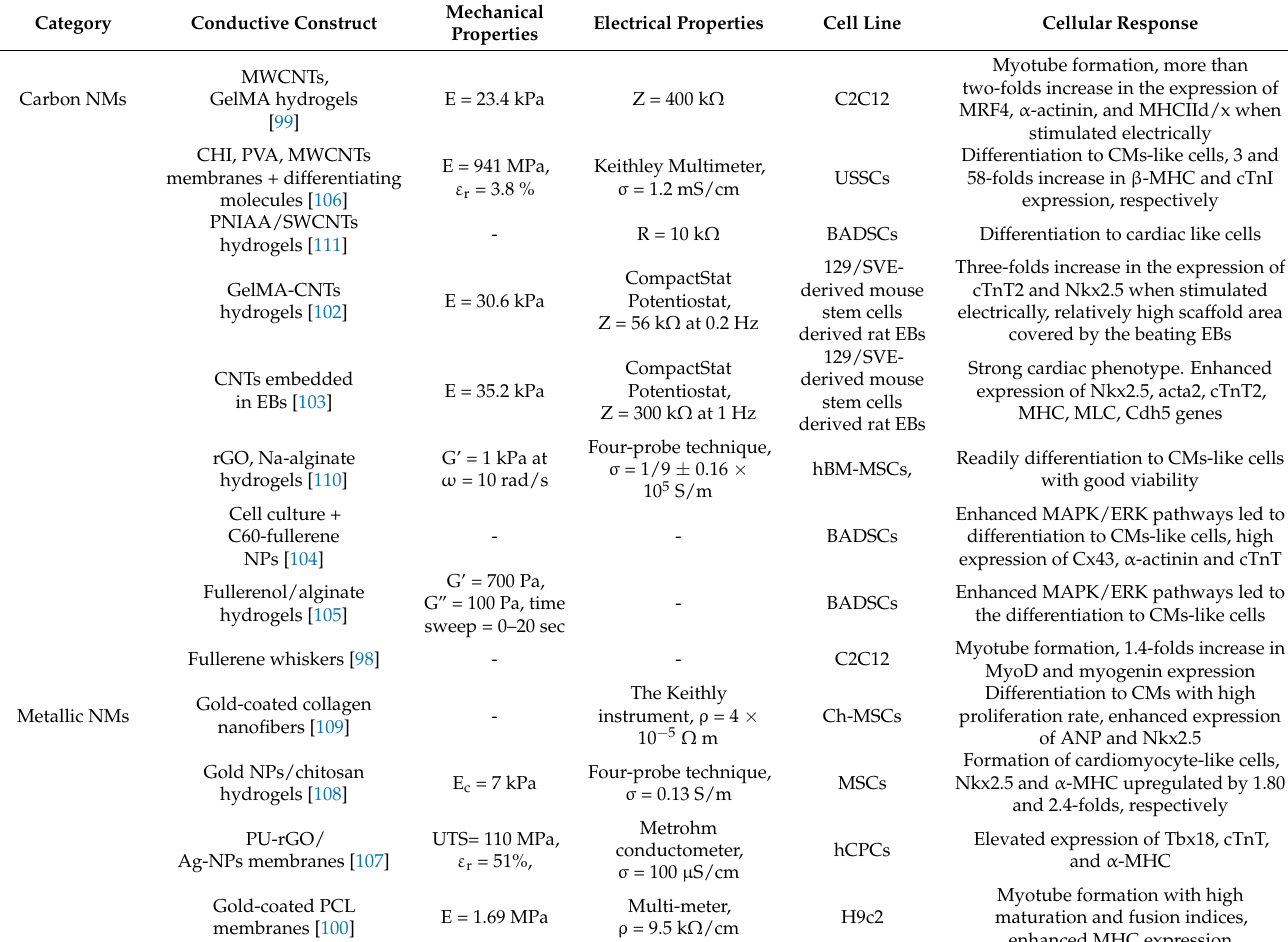
Table 3. Effect of conductive nano-construct on cellular